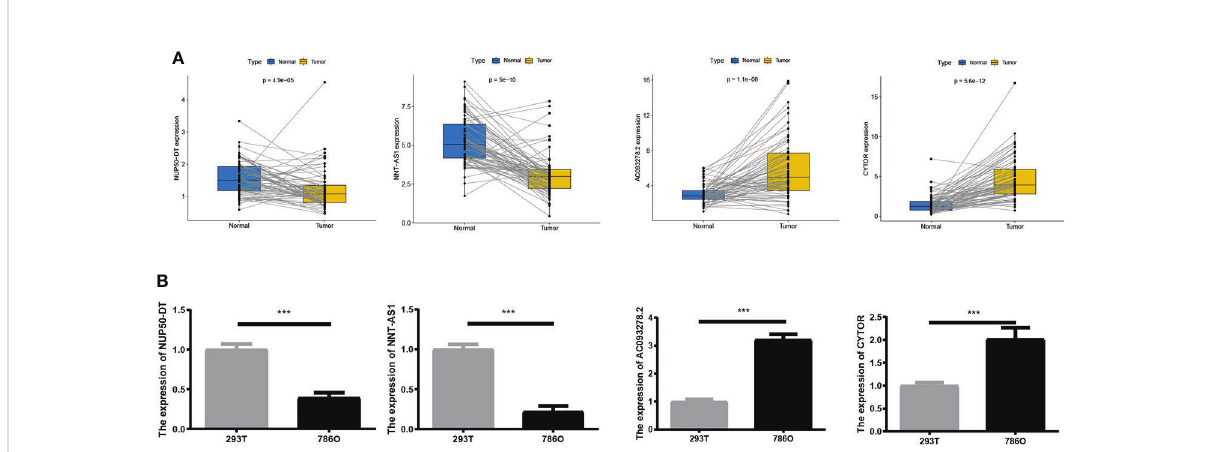
FIGURE 3 (A) Expression of four lncRNAs in KIRC and normal samples from The Cancer Genome Atlas. (B) A qRT-PCR analysis was conducted to detect the expression levels of four lncRNAs among 786O and 293T cells. The meaning of the symbol *** is p<0.001.